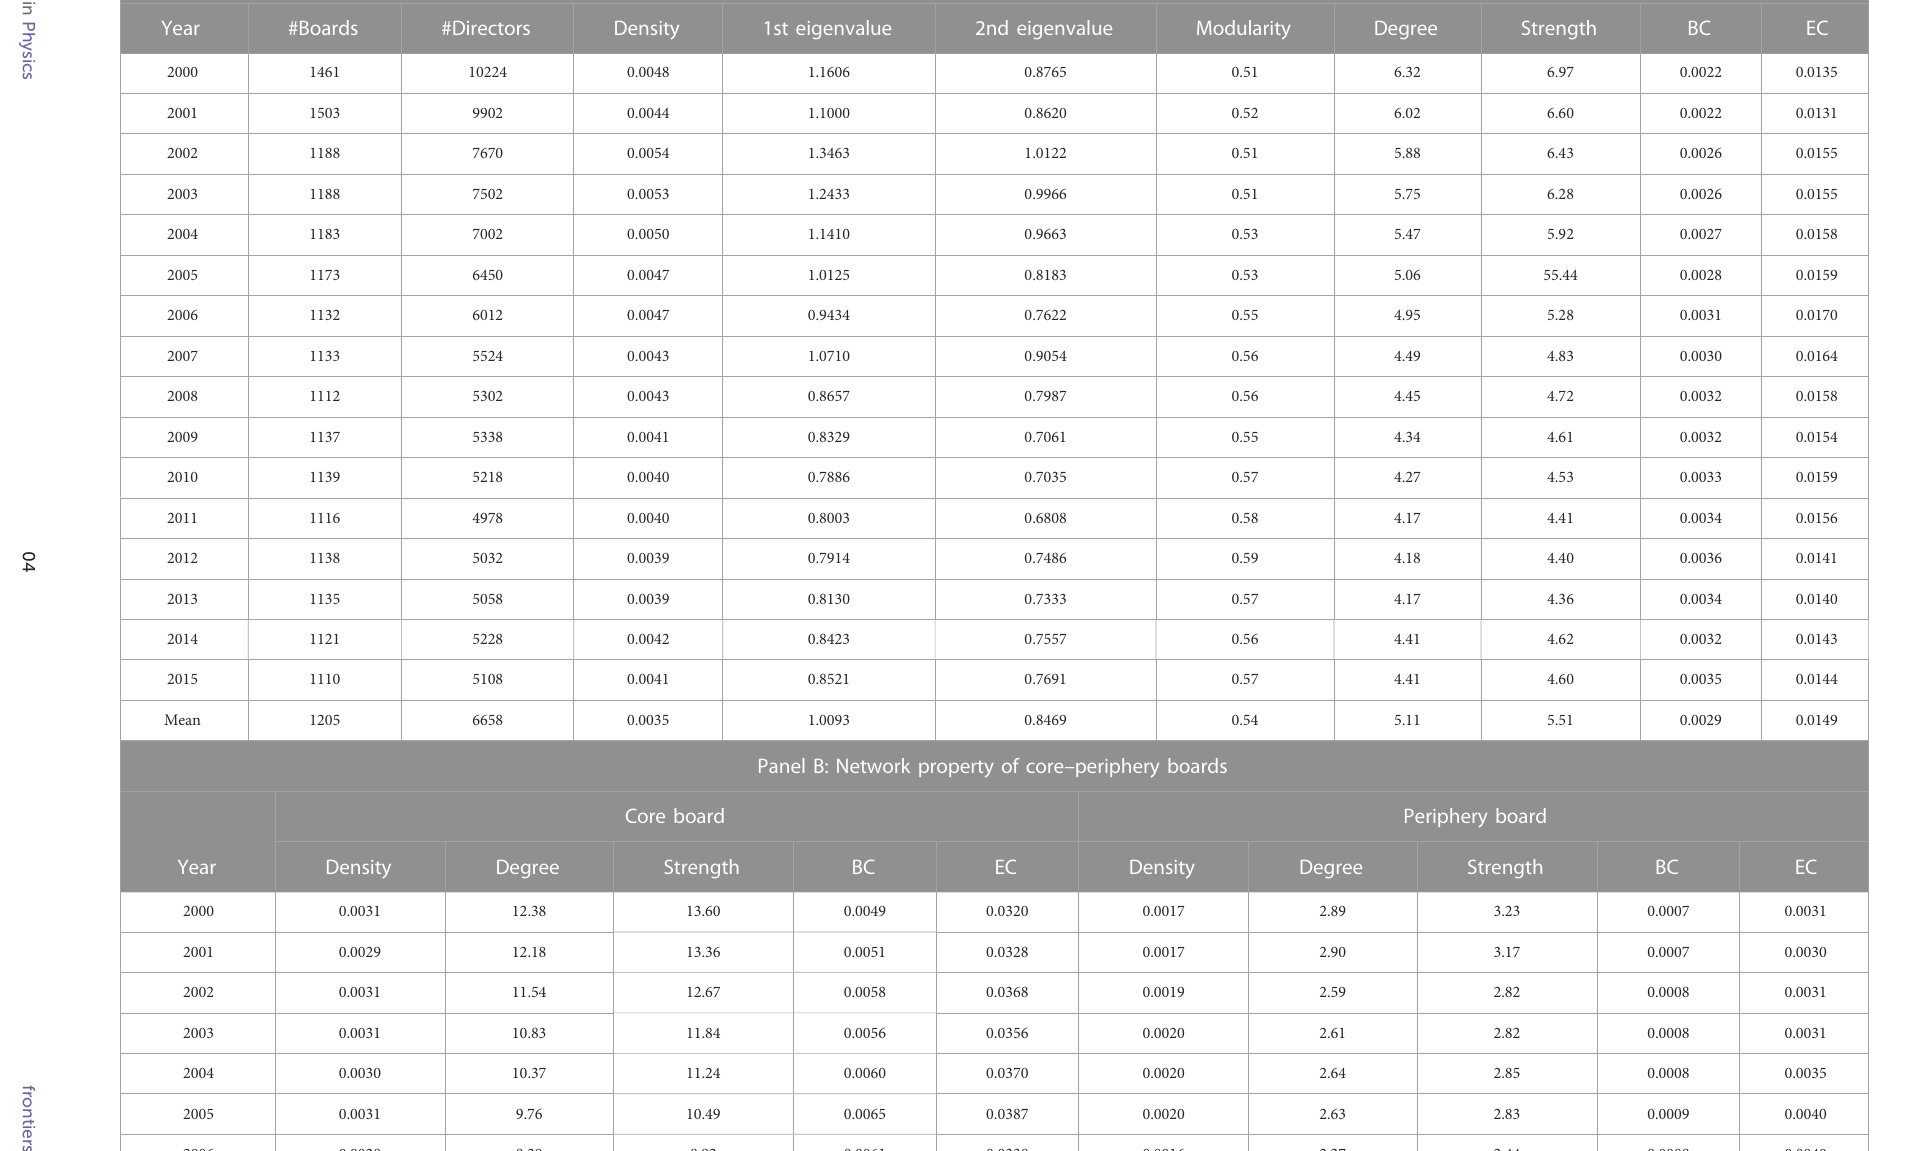
Panel A: Statistical property of board